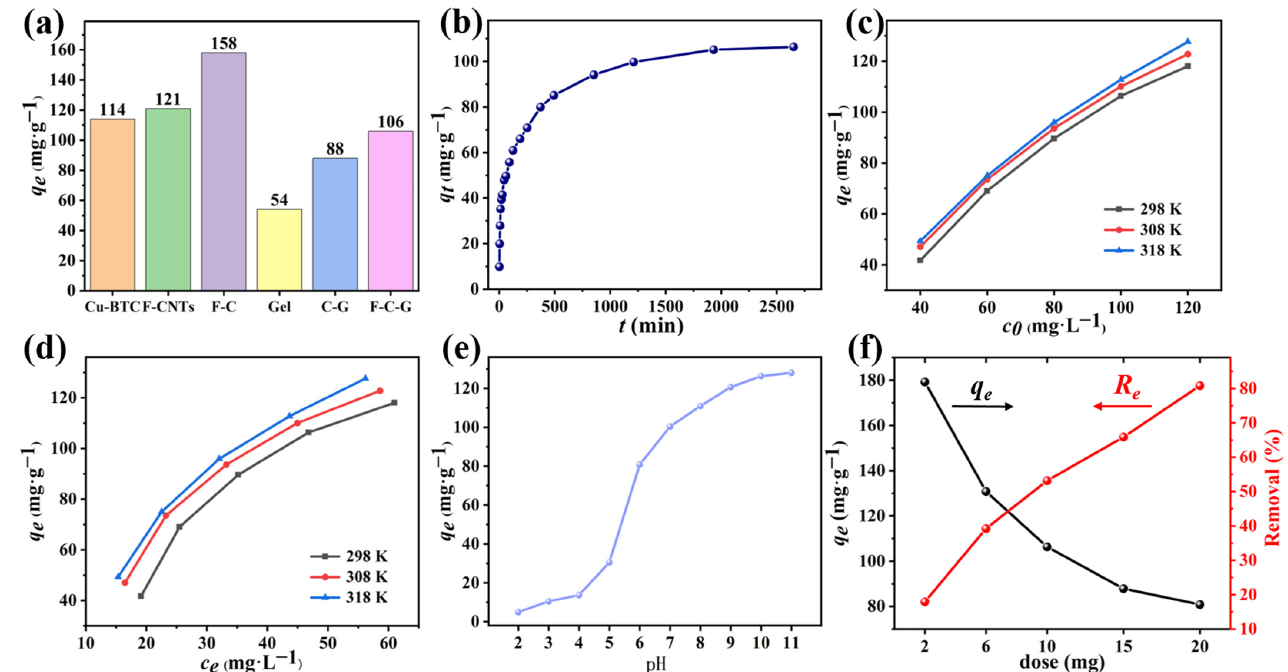
Figure 5. Comparison of adsorption capacity of different materials ( a ); Effects of time ( b ), initial concentration ( c ), temperature ( d ), pH ( e ), dose ( f ) on the adsorption process. concentration ( c ), temperature ( d ), pH ( e ), dose ( f ) on the adsorption